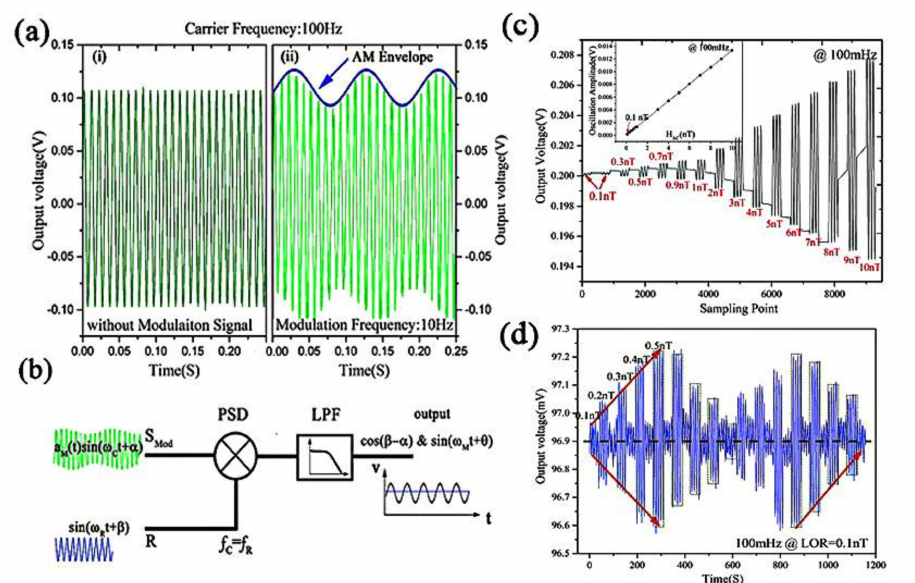
Figure 5. ( a ) The demonstration of fundamental modulation and frequency mixing phenomenon in ME sensors; ( b ) A block diagram of the amplitude demodulation method with respect to amplitude modulation signal S Mod (t). ( c ) The measured output waveform in response to an applied weak AC magnetic field at 100 mHz. ( d ) A linear-response to varying H AC at 100 mHz with a step of 0.1 nT